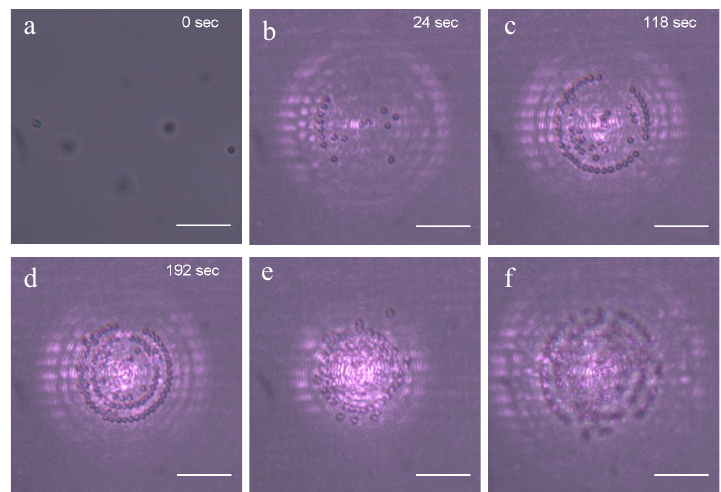
Figure 2. Images of the assembly formed by the diffraction pattern. ( a ) before the laser working; ( b – d ) generation of particles ring structure at the interface; ( e , f ) the radius of rings varied. The laser beam is irradiated perpendicularly to the imaging plane, and the power is 450 mW. The number concentration of 1 µ m particles in the solution is 2 × 10 8 cm − 3 ; scale bar, 10 µ